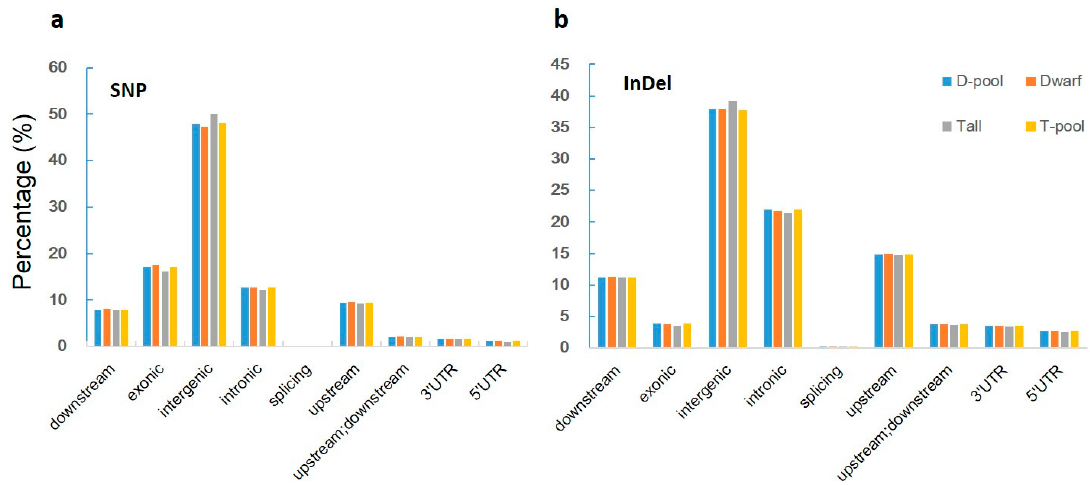
Figure 3. Percentage of SNPs and InDels in various locations for each sample. Tall: tall parental line G184-189; Dwarf: dwarf parental line YA2016-12; T-pool: bulked DNA pool for extremely tall individuals from the F 2 population; D-pool: bulked DNA pool for extremely dwarf individuals from the F 2 population. Downstream: variant overlaps 1-kb region downstream of transcription end site; exonic: variant overlaps a coding exon; intergenic: variant is in an intergenic region; intronic: variant